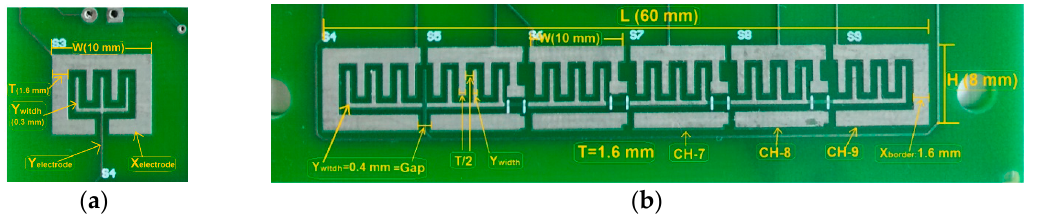
Figure 5. The shape of an electrode of mutual-capacitive ( a ) single sensor; ( b ) slider on the bottom layer.